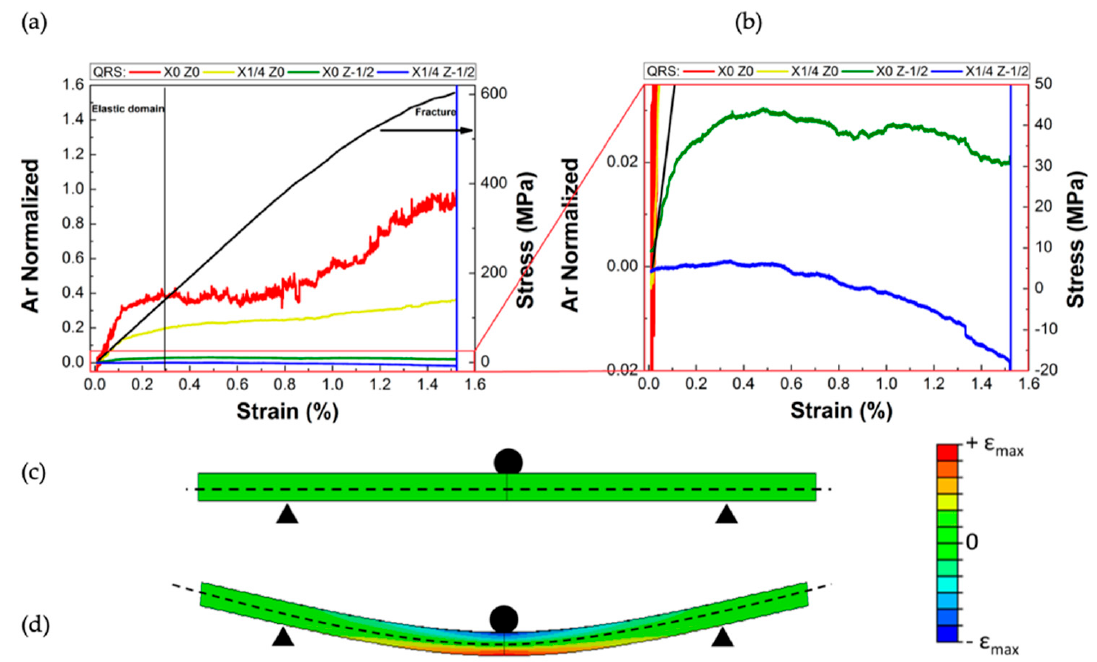
Figure 4. Electrical behavior of four QRS located at four different spots in the CFRP sample, below the central span (identification X0), or in the middle along the side of the sample (X1/4), and one ply below the surface (Z0) or close to the neutral axis (Z-1/2). ( a ) Normalized Ar of the four QRS as a function of the maximum strain below the central span during static three-points bending test. ( b ) Magnification of curves for (X0; Z-1/2) and (X1/4; Z-1/2). Modelling of the strain field during the three-points bending experiment at ( c ) initial state and ( d ) during bending.